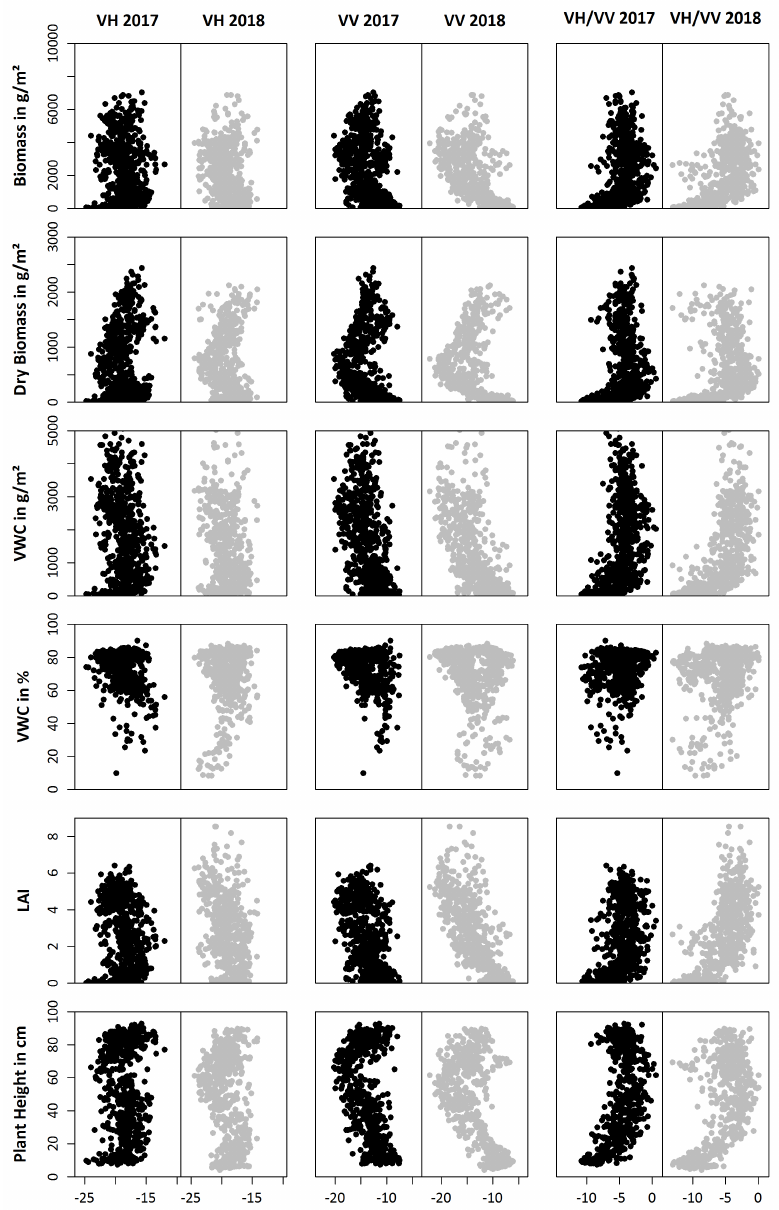
Figure 15. Scatter plots of crop parameters related to backscatter parameters for all wheat fields in 2017 (black points) and 2018 (gray